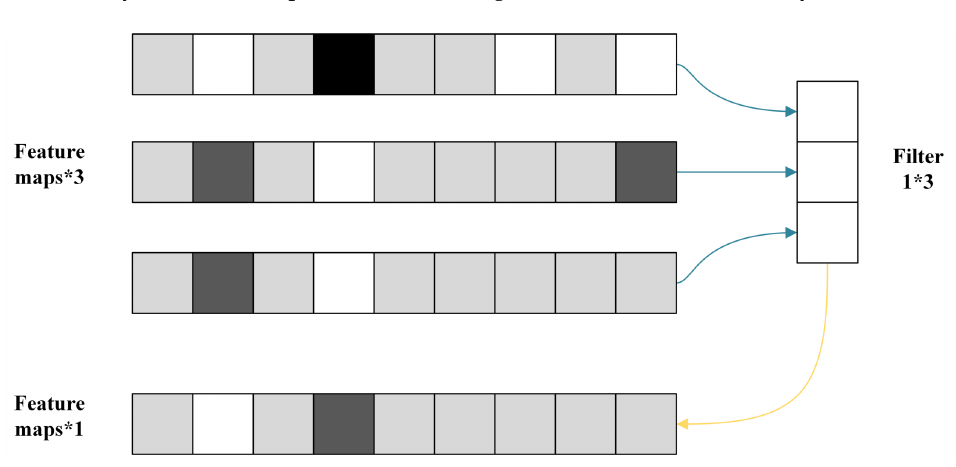
Figure 5. Pointwise convolution.